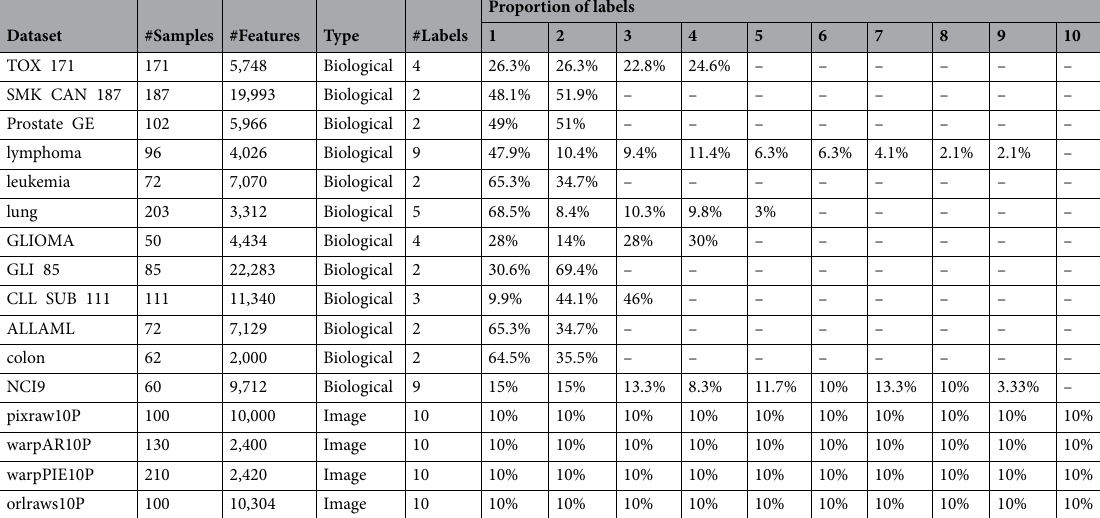
Table 1. Benchmark Datasets Specifications.